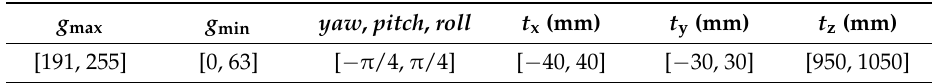
Figure 5. Chessboard images captured by ( a ) simulation and ( b ) real device. Table 1. Range set of simulation parameters. yaw , pitch , and roll are the Euler angles related to r . t x , t y , and t z are the dimensional elements of t .